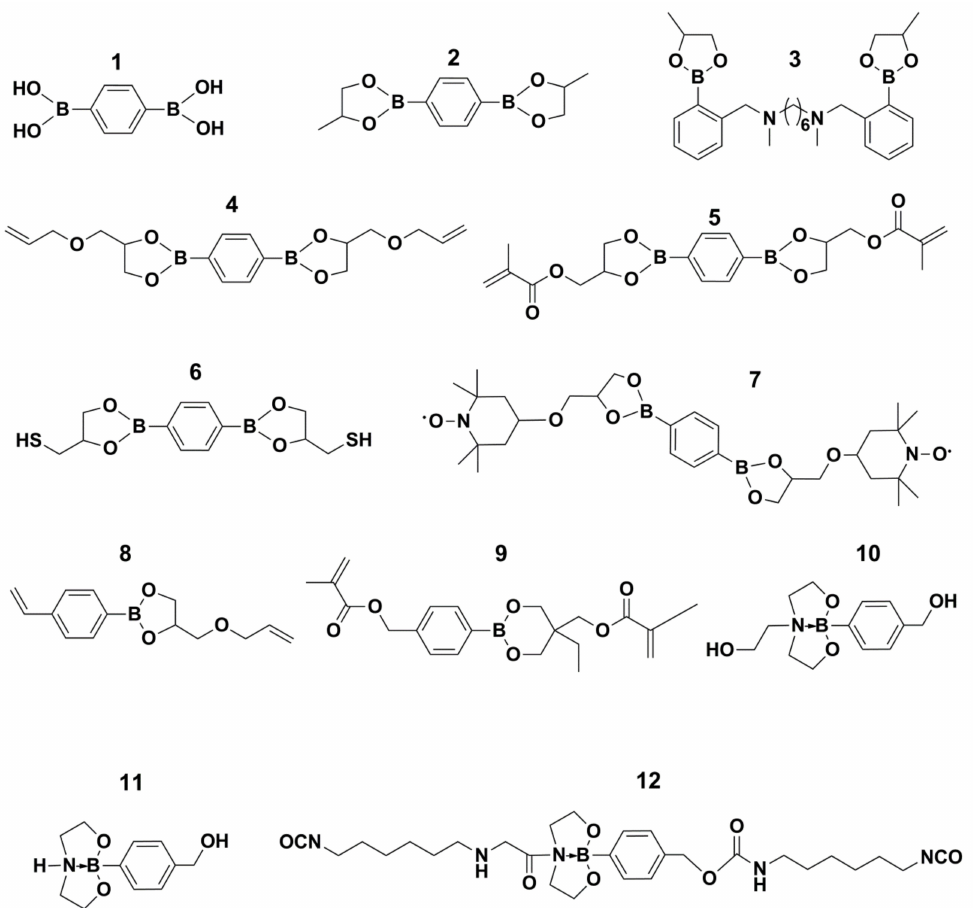
Figure 3. Structural formulas of cross-linkers applied for the formation of boronic acid esters- based